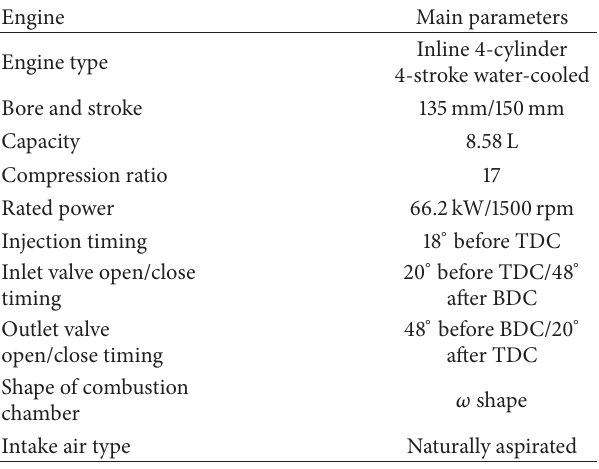
Table 1: Specifications of the 4135ACa engine.